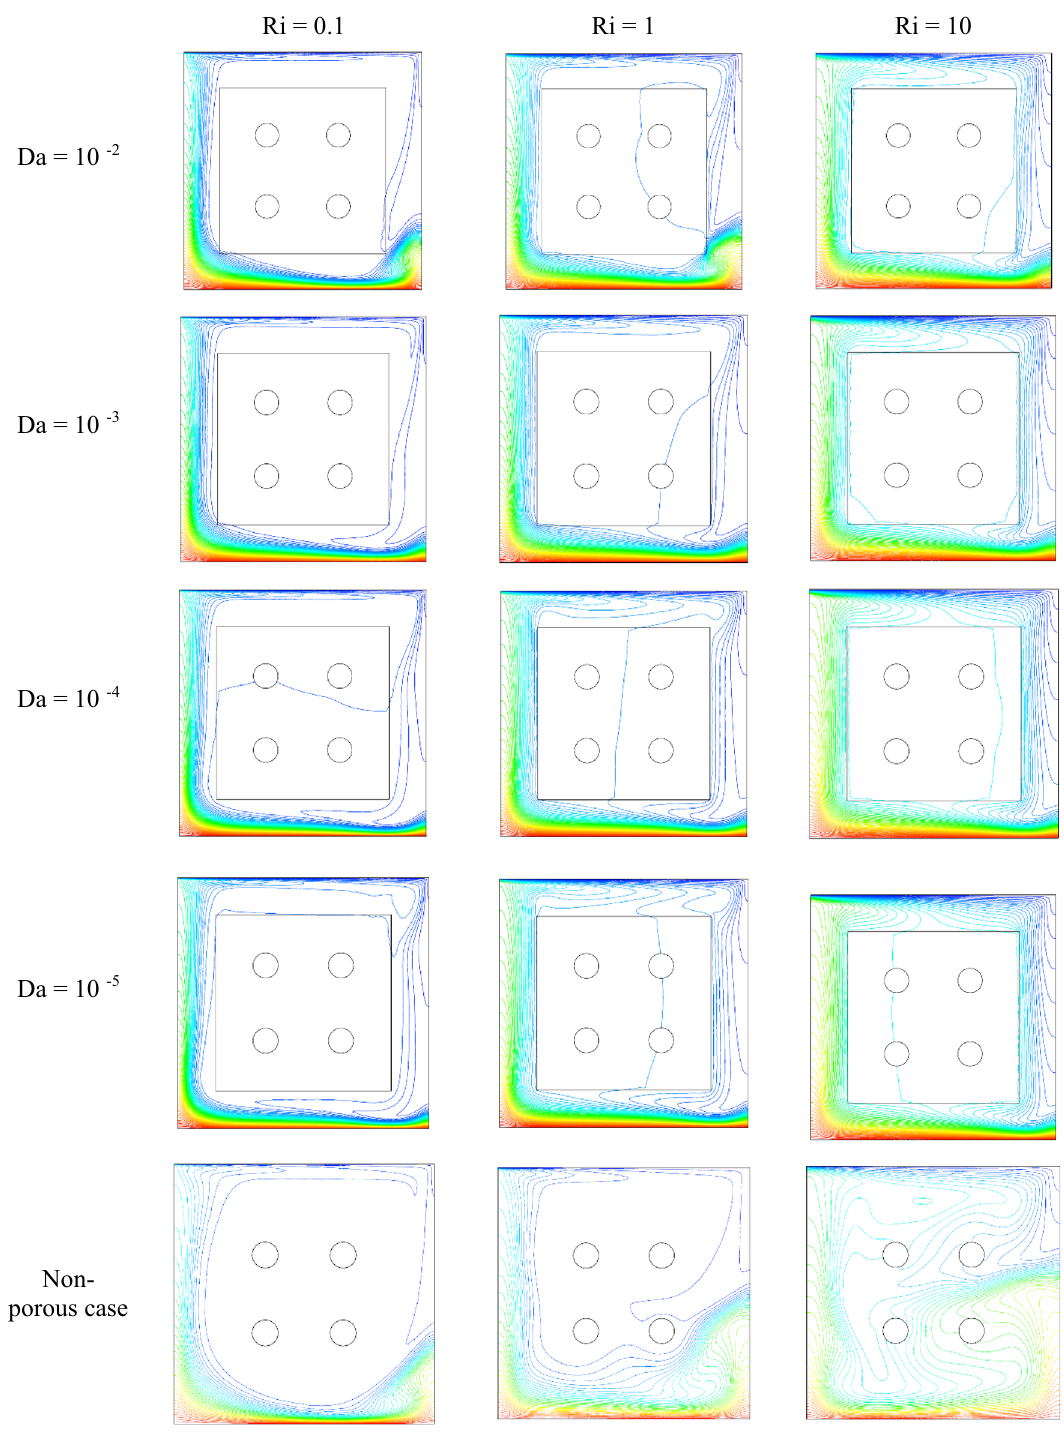
Figure 10. Dimensionless Isotherm contours for φ = 0.01, τ = 0.1, ɛ =